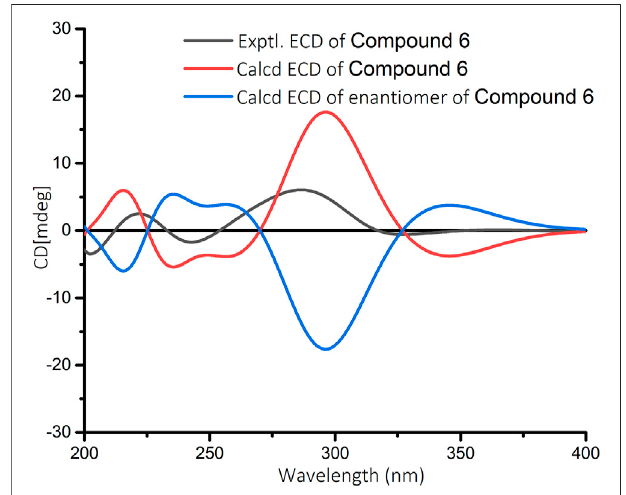
FIGURE 8 | Calculated and experimental ECD spectra for compound 5 in MeOH.